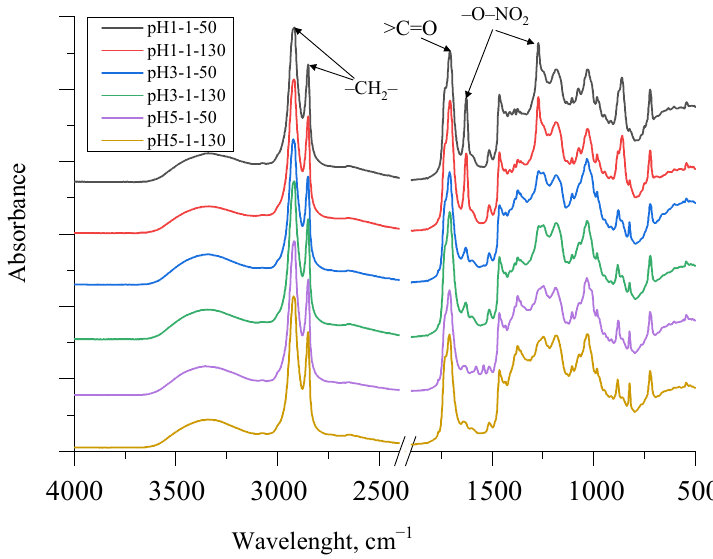
Figure 7. FTIR spectra of SA samples using different acidification and drying strategies.